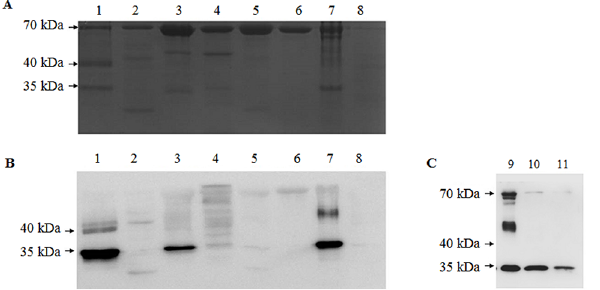
Fig 5. Western blot analysis of mVg in A . pernyi . (A) Coomassie blue-stained electrophoresis pattern of samples prepared from the tissues of various developmental stages and (B) Western blotting for mVg from the corresponding gel. Labels 1 – 8 represent eggs at day 3, larval fat body, pupal fat body ( ♀ ), pupal fat body ( ♂ ), pupal hemolymph ( ♀ ), pupal hemolymph ( ♂ ), immature eggs isolated from pupae, and moths ( ♀ ), respectively. (C) Western blotting for mVg from eggs during various developmental stages. Labels 9 – 11 represent immature eggs isolated from pupae, eggs at day 1, and eggs at day